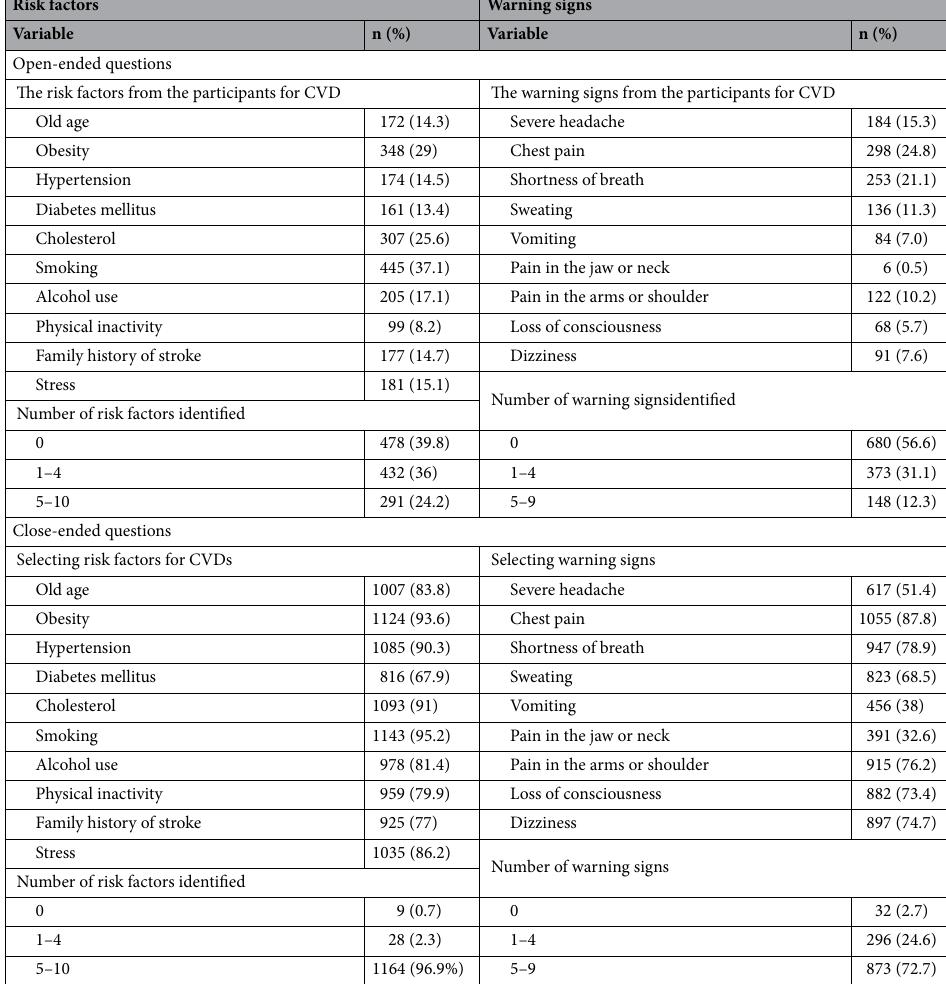
Table 2. Knowledge of risk factors and warning signs.